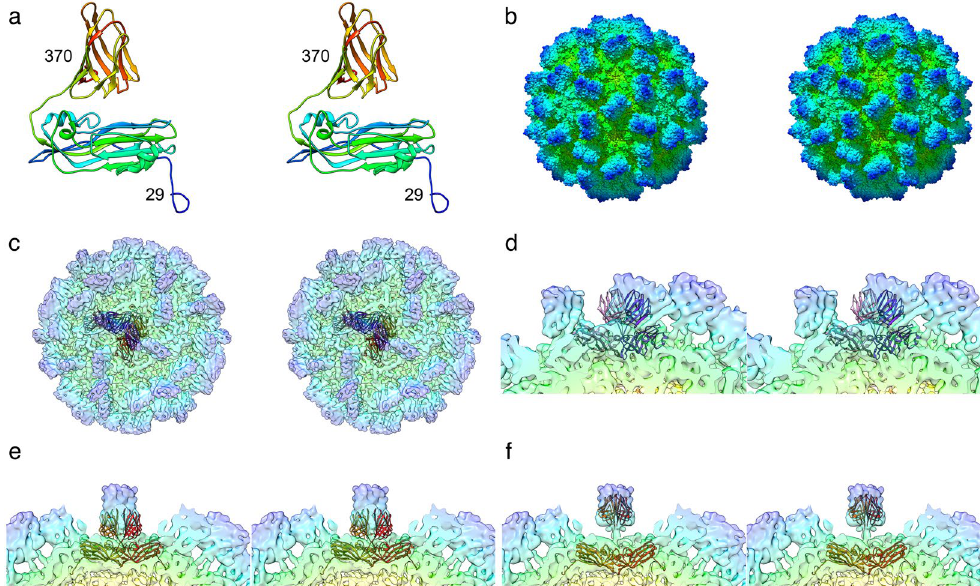
Figure 4. Homology modelling of the Mr NV capsid protein. Structure prediction has previously been used to compute a model for the MrNV capsid protein by homology modelling against cucumber necrosis virus (CNV) – PDB ID 4LLF. To test whether this model was compatible with our reconstructed density map, we repeated the modelling. Stereo pair views are presented. ( a ) A ribbon diagram of the homology model shows the reported two-domain structure. The N and C terminal residues are labelled indicating the extent of the capsid sequence that was modelled. ( b ) The solvent excluding surface representation of the CNV capsid structure that informed the homology model reveals a clear dimer-clustered T = 3 assembly. ( c ) A transparent view of the MrNV reconstruction, into which we have inserted AB dimers (purple/pink) and CC dimers (red/orange) of the homology model. A close-up view of the AB-dimer ( d ) shows that there is poor correlation between the positions of the P domain in the homology model and reconstructed density map. Likewise, the reconstructed density for the MrNV P-domain at the CC position is also differently positioned from that predicted by the homology model, the feature is significantly raised from the capsid surface and rotated ( e ). Rigid-body fitting of the individual S and P domains at the CC-dimer position gave reasonable results, although the shape of the CNV P-domain is broader than the thin, blade-like structure in MrNV ( f